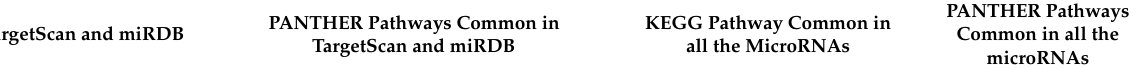
Table 4. List of common pathways in TargetScan and